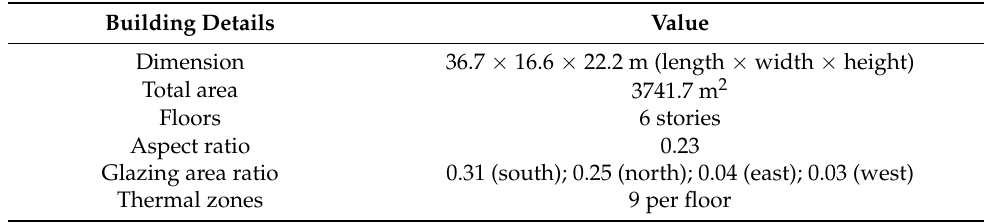
Table 2. Building model form details.